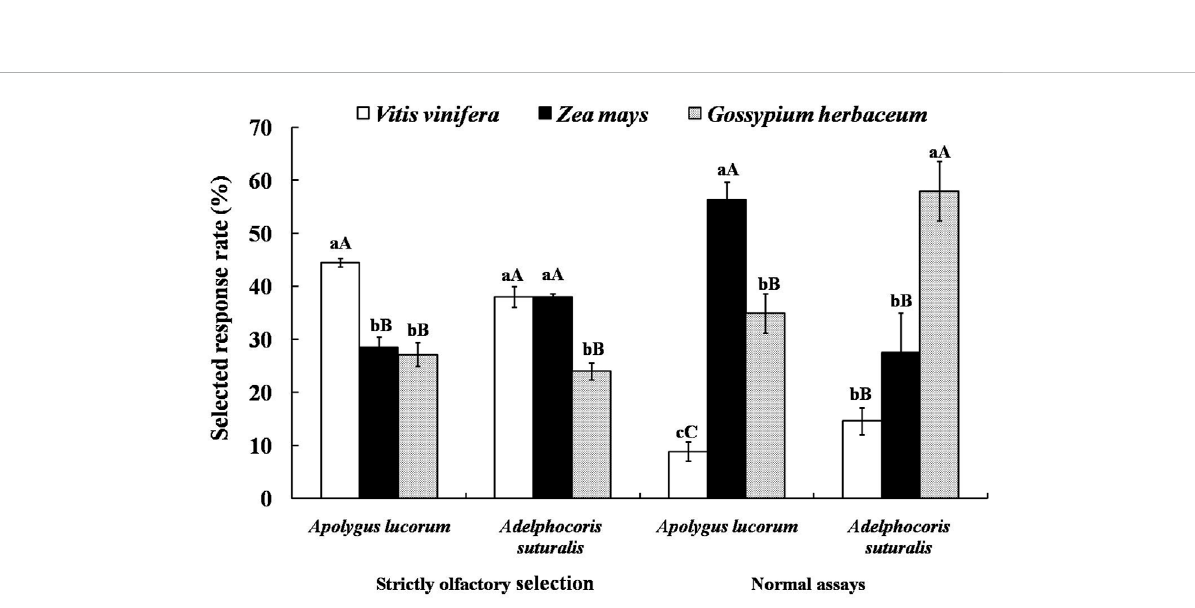
FIGURE 5 Attractive effectsofdifferenthostplantson A.suturalis andA.lucorum.Differentuppercaseandlowercaselettersshowedextremely signi fi cant ( p < 0.01) and signi fi cant ( p < 0.05) differences of the selected response rate of mirid bugs to different hosts in two modes of behaviour tests respectively ( Least Signi fi cant Difference test